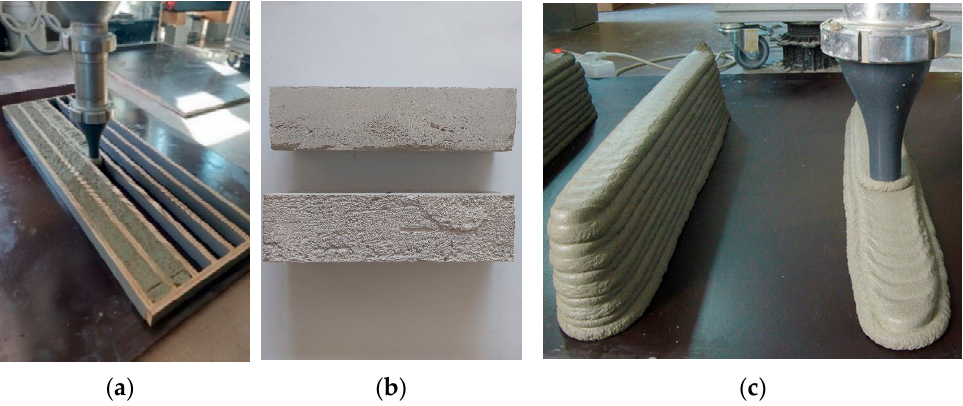
Figure 2. Printed models in molds for mechanical strength tests ( a ), demolded printed models for mechanical strength tests (top—side surface; bottom—top surface ( b ), and frost resistance tests ( c ). Next, the samples for frost resistance tests were printed—500 mm long straight lines consisting of 10 layers—each 10 mm high and 50 ± 5 mm wide, printing speed of 1200 mm/min, which were divided into 100 mm wide samples whilst still in fresh state 40–60 min after printing The reference samples were cast at the same time as 3D printing was carried out—the mortar was filled into the molds without extruding it through the printhead. Mold- ing of test samples was carried out according to provisions of EN 12390-2 [23] and EN 196-1 [24]—4 cubes were cast and later on sawed in half for freeze–thaw testing, in addition, 6 samples sized 40 × 40 × 160 mm were cast for strength